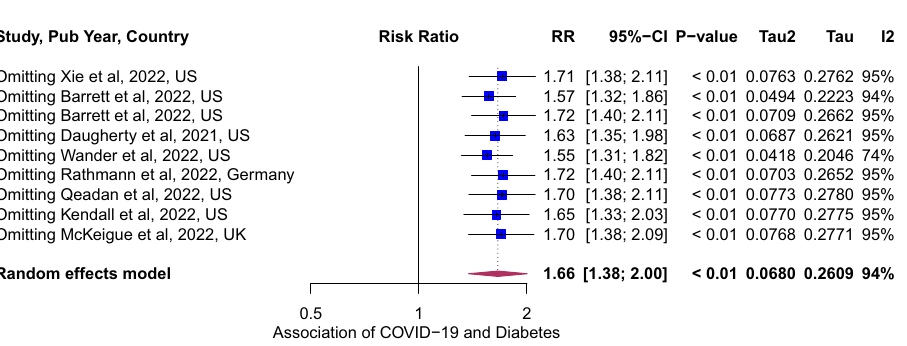
Figure 6. Influence and outlier (leave-one-out meta-analysis) analysis for the association of COVID-19 and incident diabetes 27 . The results of our outlier and influence analysis show the recalculated pooled point estimate ranged from 1.55 to 1.72 when one study was omitted each